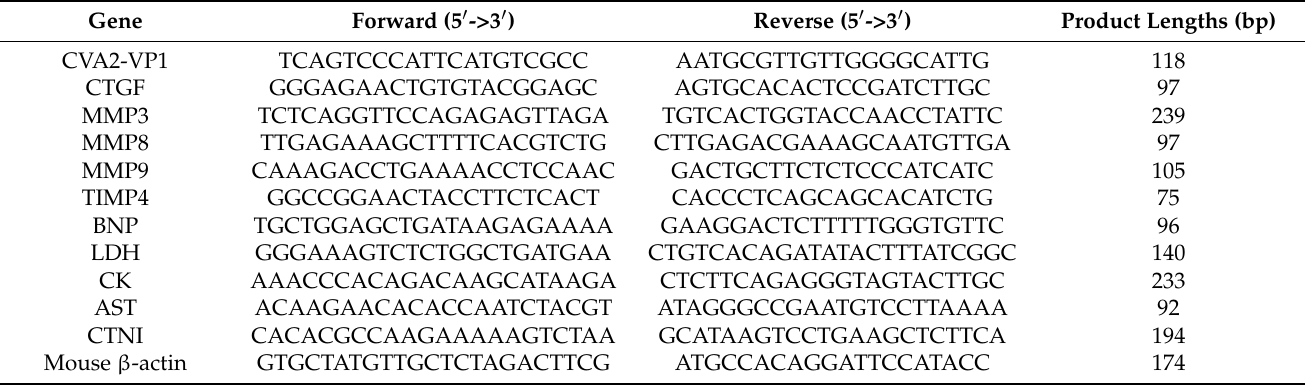
Table 1. Primers used in this